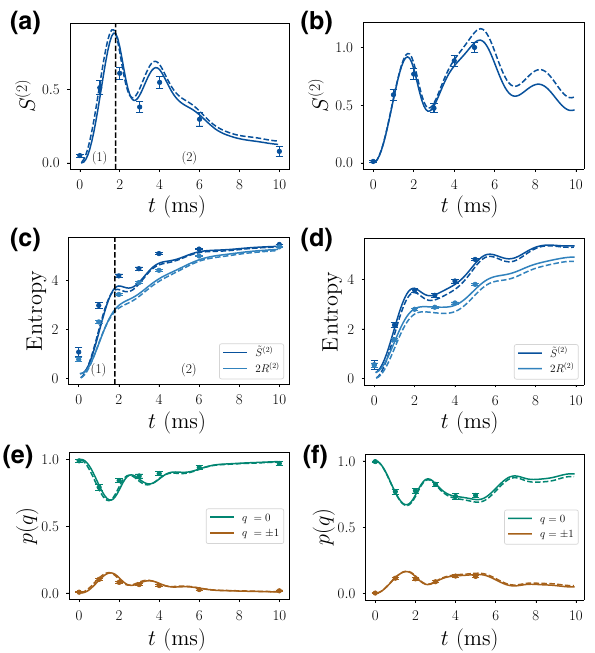
FIG. 2. Additional experimental observations: (a),(b) the mea- sured Rényi 2-OE and, correspondingly, (c),(d) the measured ˜ values of S ( 2 ) (ρ AB ) and R ( 2 ) (ρ AB ) relating to Rényi 2-OE as in Eq. (16) for a reduced density matrix of four ions from a total system consisting of N = 20 (left panels) and N = 10 (right pan- els). We observe the two phases of the entanglement barrier, which are separated by a black vertical dashed line for (a) and (c), given by: (1) the growth phase followed by (2) the decay phase. (e),(f) The corresponding populations p ( q ) for symmetry sectors q = 0, ± 1, on a reduced density matrix of four ions taken from their respective total systems of N = 20 and N = 10. The points show experimental results with the error bars calculated using jackknife resampling. The lines correspond to numerical simula- tions of the unitary dynamics (dashed) and including dissipation